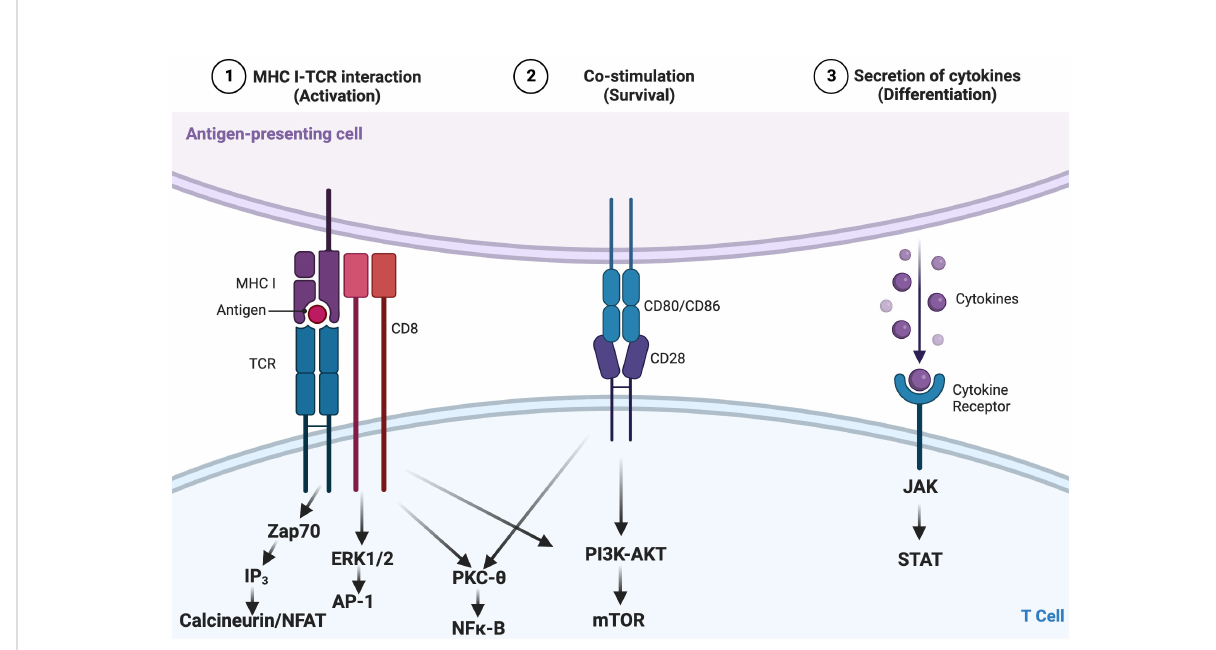
FIGURE 1 Canonical three-signal activation model for T cells. Activation is dependent on integration of three signals: 1) recognition by the T-cell receptor (TCR) of an antigen presented as a peptide by the major histocompatibility complex (pMHC) on antigen-presenting cells (APCs); 2) costimulation, which lowers the stimulation threshold of naïve T cells, prevents anergy, and enhances cytokine production; and 3) cytokine signaling along the JAK-STAT pathway, which ampli fi es the clonal expansion, survival, and differentiation of T cells. These converging cellular signaling cascades in fl uence the activation and differentiation status of T lymphocytes, in this case, CD8+ T cells. Adapted from “ Three Signals Required for T cell Activation ” , by BioRender.com (2022). Retrieved from https://app.biorender.com/biorender-templates/t-